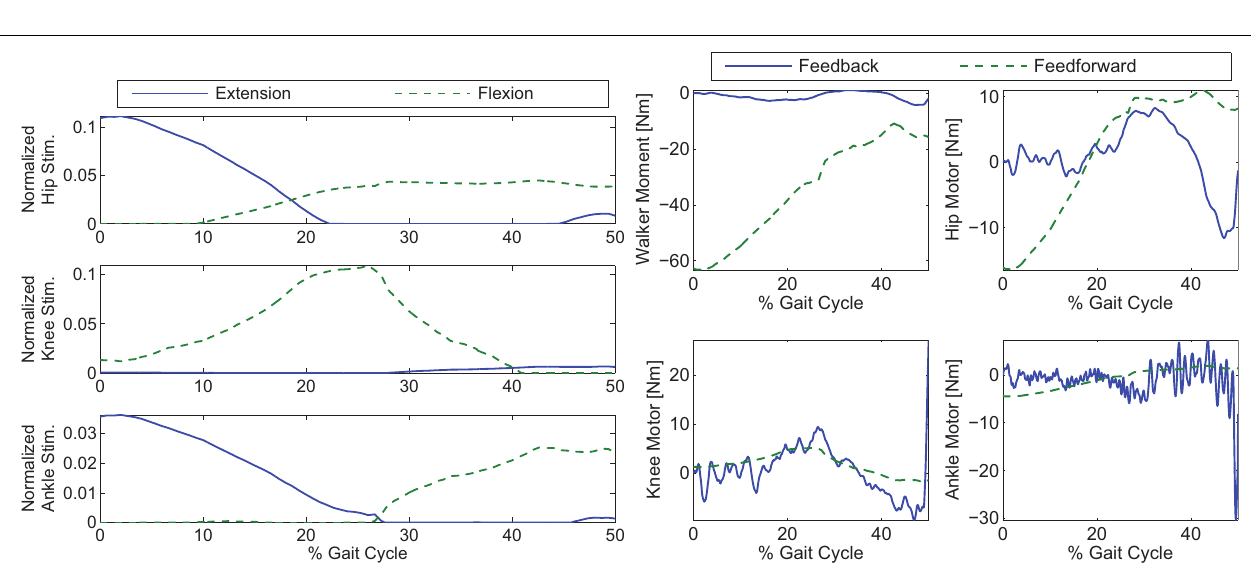
FIGURE 8 | Control inputs for Case 3 of the simulations . The feedback’s contribution was used only in the walker moment and motor torques.